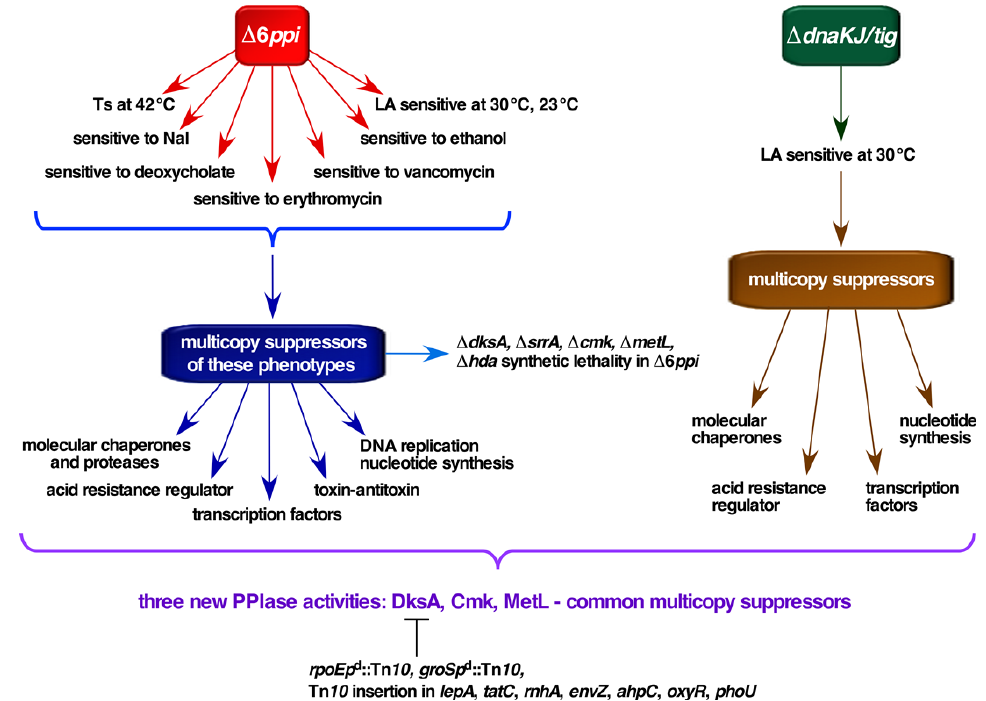
Figure 1. Schematic presentation of approach employed to identify factors that are limiting in Δ6 ppi and Δ( dnaK / J tig ) bacteria using multicopy suppressor approach. This identified several factors, whose overexpression can rescue their lethal phenotype. This identified transcription factor DksA, aspartokinase MetL and cytidylate kinase Cmk as common factors whose overproduction can restore growth and these factors also exhibit peptidyl cis / trans prolyl isomerase activity. Further, DksA-mediated suppression requires wild-type levels of GroL/S and RpoE, and it is abolished when either genome integrity is compromised in the absence of RNase H or in the absence of translational GTPase LepA or when cell envelope homeostasis is dysfunctional.